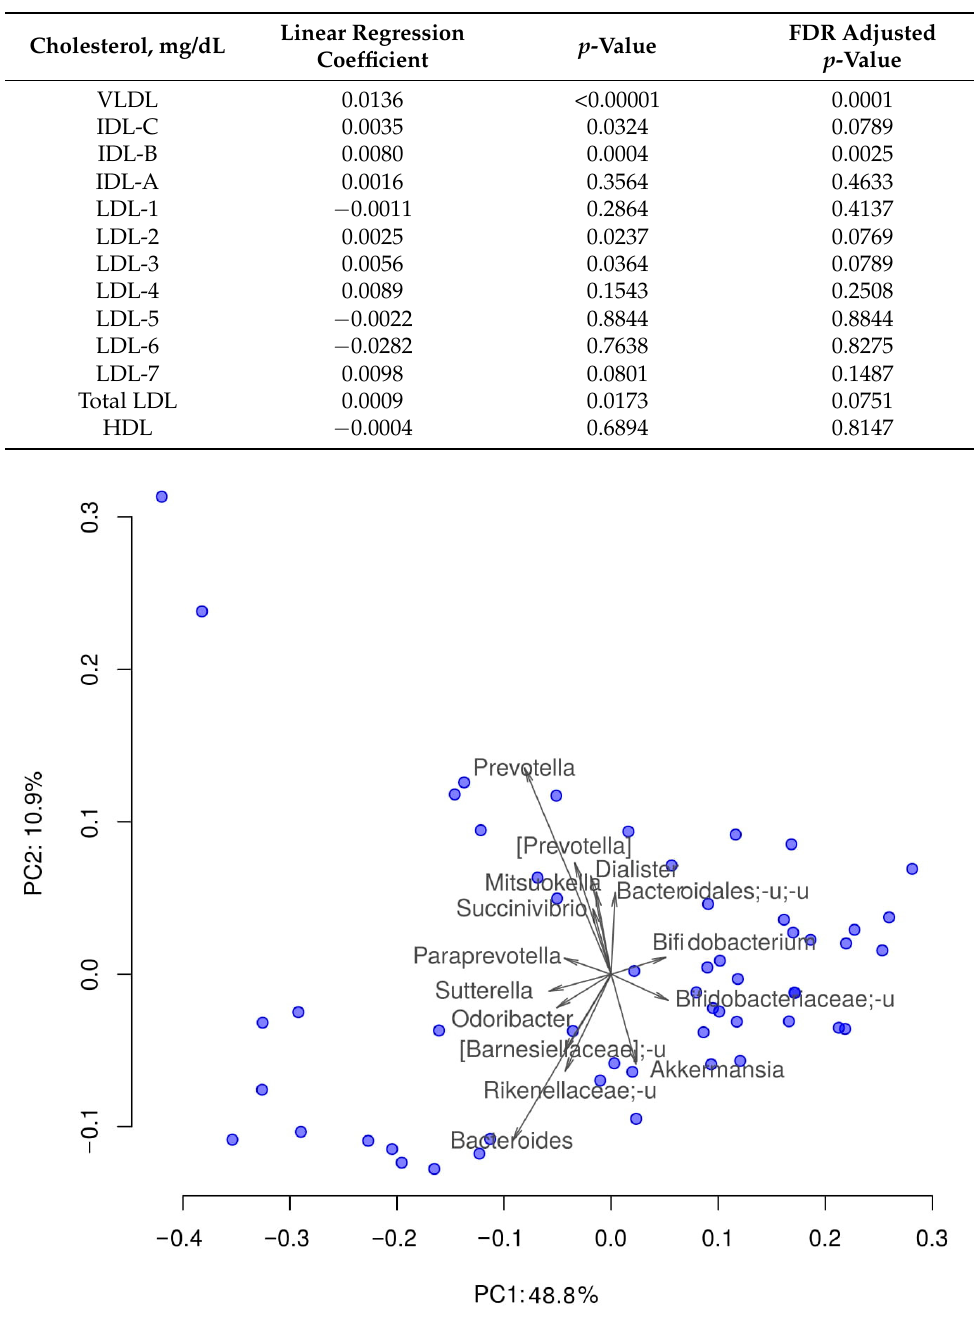
Figure 1. Distribution of the samples by their taxonomic composition in reduced dimensionality. PCoA (Principal Coordinate Analysis); dissimilarity metric: weighted UniFrac. Prefix “_u” denotes all unclassified taxa from the higher taxonomic rank. Arrows show the top 15 taxa in terms of the explained variance in given axes. The arrows’ length is proportional to the percent of variance explained by the taxon. The arrows’ angle reflects the distribution of this variance between the axes.